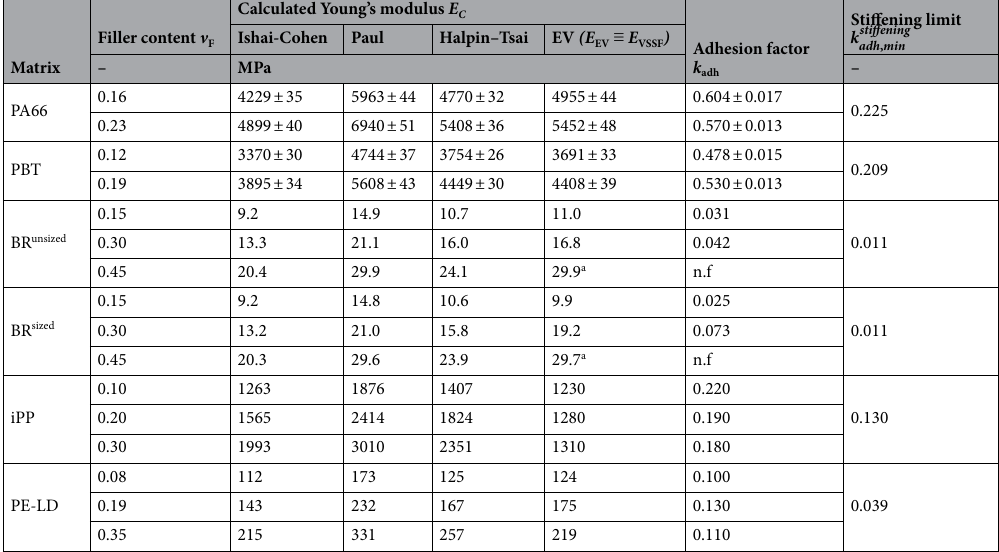
Table 4. Comparison of calculated GB content dependent Young’s moduli with evaluated adhesion factors k adh and its minimal stiffening limit k n.f. means “no fit